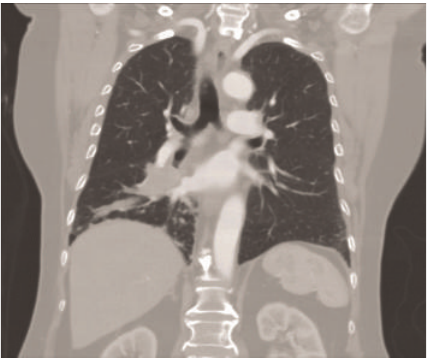
Figure 1: Transverse section on a chest CT demonstrating the presence of tumor lesions in the right middle and lower